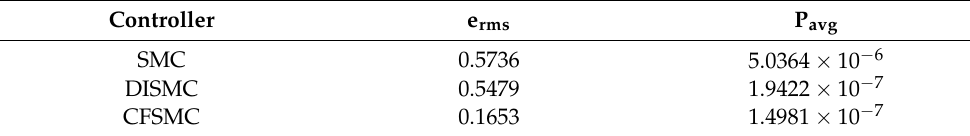
Table 4. Comparison of SMC, DISMC, and